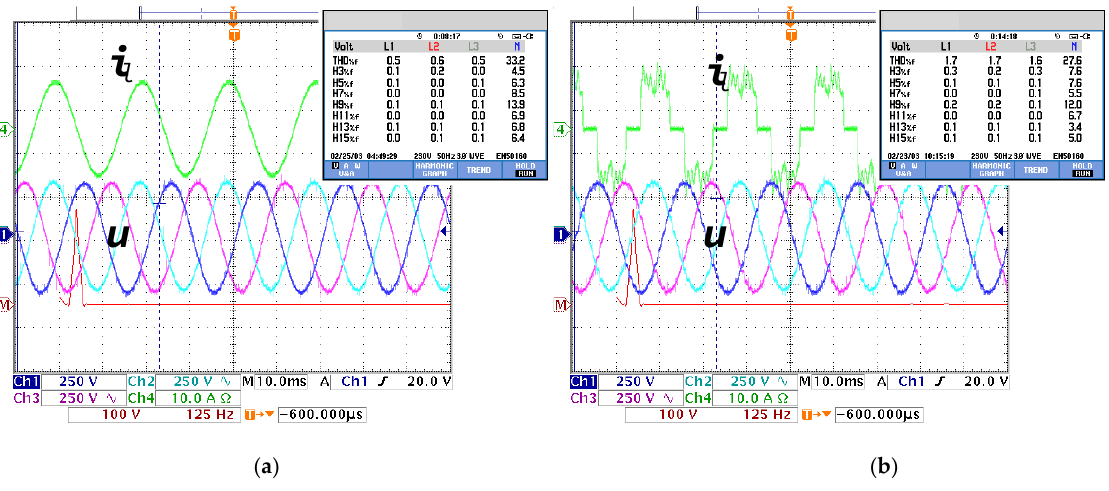
Figure 8. Steady waveforms and the total harmonic distortion (THD) of the proposed optimal control law under nominal LC filter parameters (2 mH, 30 μF): ( a ) linear load, ( b ) non-linear load.